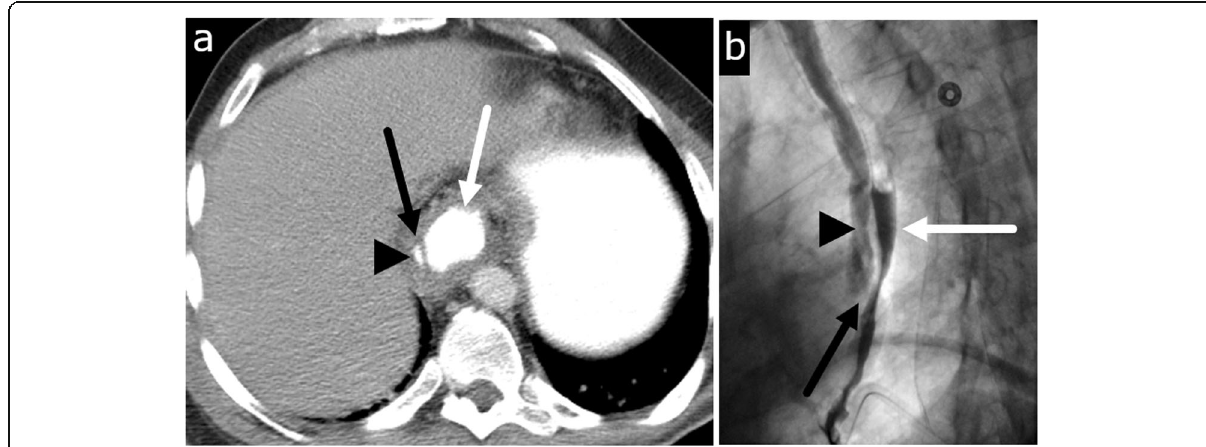
Fig. 9 Intramural dissection. Fifty-one-year-old male with chest pain radiating to the back after forceful vomiting. a Axial CT image shows an intramural dissection flap (arrow) between the true (arrowhead) and false lumen (white arrow) in the lower esophagus. b Barium esophagography shows two parallel lumens and an intervening dissecting flap filling defect (black arrow) giving the esophagus the double barrel appearance. True lumen (arrowhead). False lumen (white arrow)